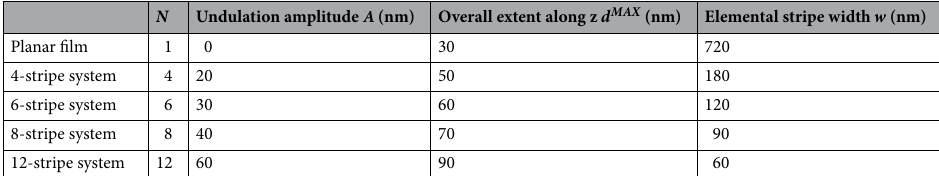
Table 1. The 5 systems under investigation and the corresponding overall extent along the z direction, undulation amplitude, and width of the elemental stripe forming the primitive cell.